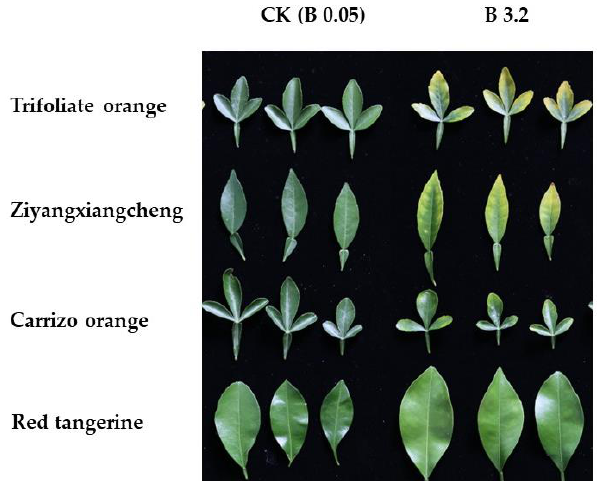
Figure 1. The toxicity symptoms of leaves under B 3.2 for four citrus rootstocks in 42 DAT. Table 1. The time to the occurrence of symptoms of B injury in four citrus rootstock seedlings.